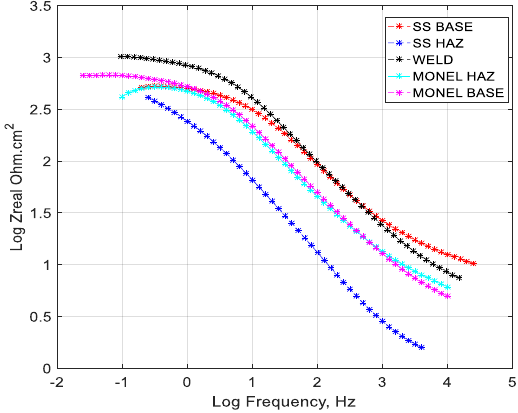
Figure 15. Bode plot for HT specimen.